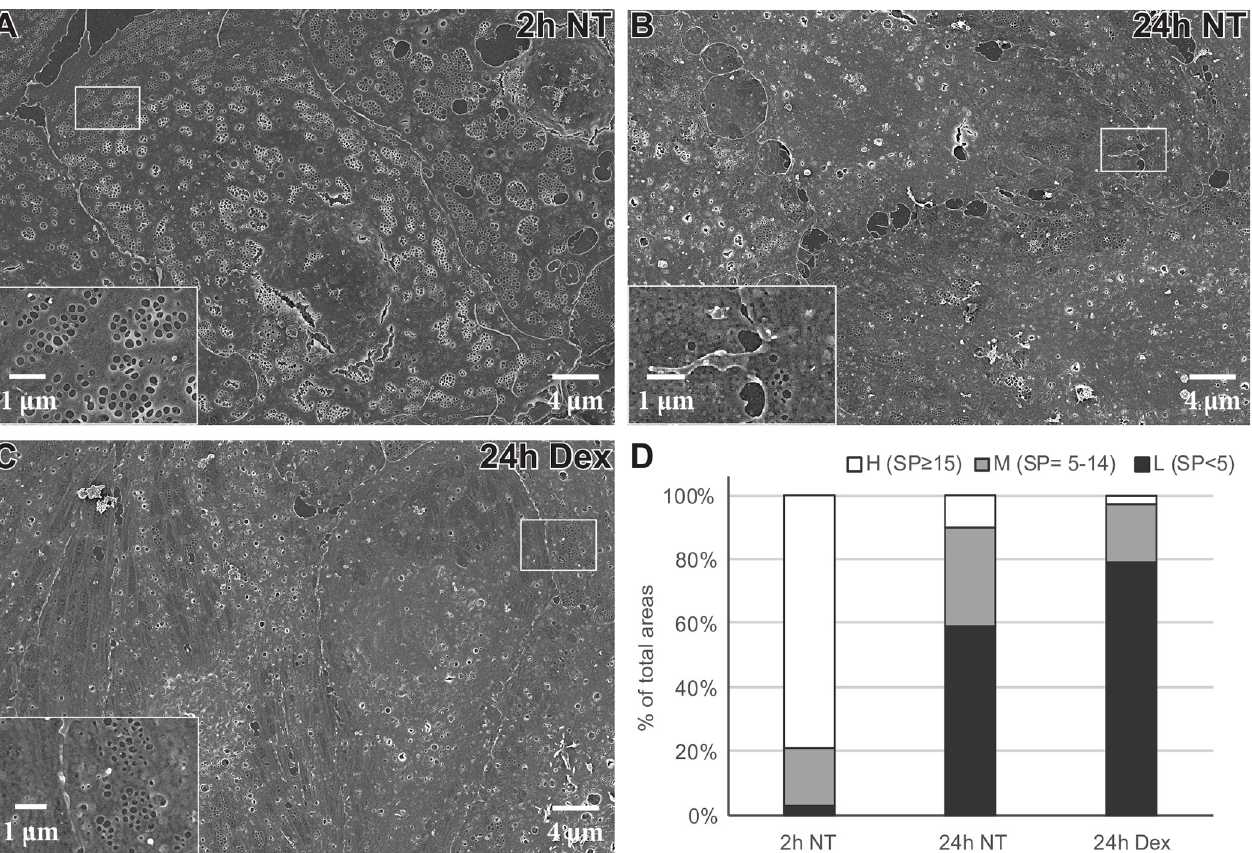
Fig 10. Effect of Dex on rat LSEC morphology in early primary cultures. (A-C) Scanning electron micrographs of LSECs cultured for the indicated time points in the presence or absence of 1 μ g/ml Dex. Inserts show sieve plates (A-C) and cell borders (B, C) at higher magnification. (D) Extent of LSEC surface area with high density (H, � 15 sieve plates (SP)/area), medium density (M, 5–14 SP/area), and low density (L, 0–4 SP/area) of fenestrae organized in SP in percent of total LSEC surface area, at the indicated time points and treatments. The number of SP was counted per 400 μ m 2 squares on images from randomly picked larger areas in the LSEC cultures. At least 100 squares were scored for each treatment in each experiment. The average values of 3 biological replicates are presented in the figure. The observed changes in % highly fenestrated areas were significant between 2 and 24 h (one-way ANOVA, p < 0.05, n = 3) but not between Dex- and non-treated groups at 24